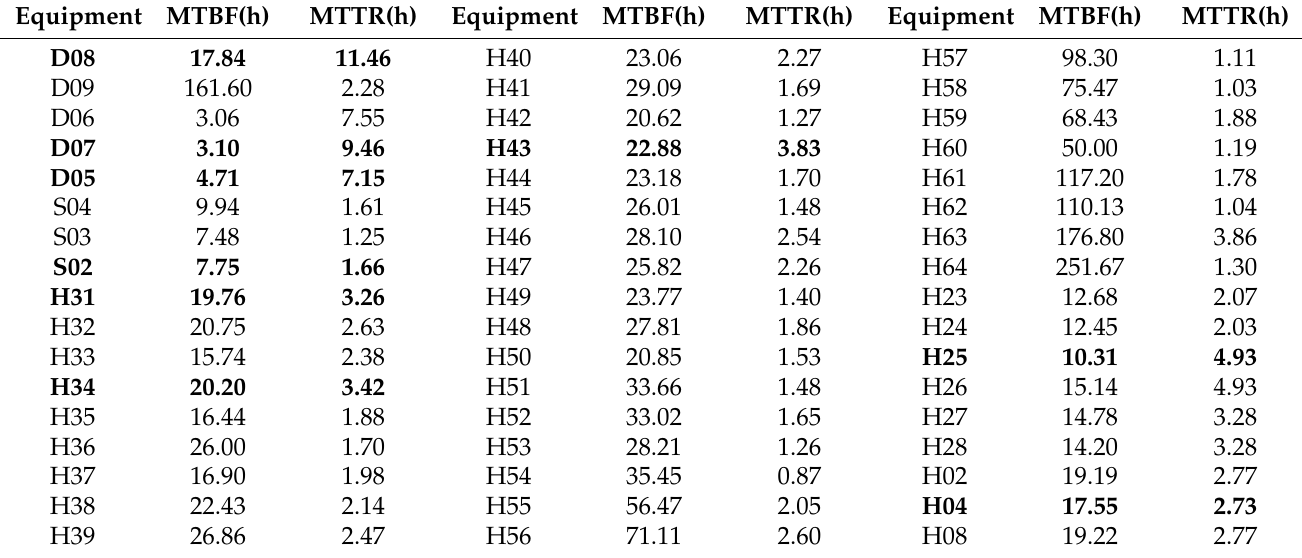
Table 2. Reliability and maintainability parameters of the fleet equipment.